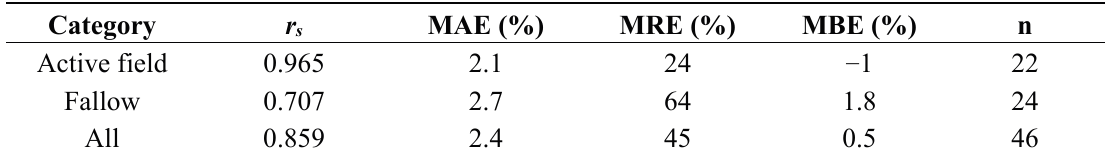
Table 9. Results of accuracy assessment for the delineation of tree canopy cover presented by Spearman’s Rho correlation coefficient ( r s ), mean absolute error (MAE), mean relative error (MRE), and mean bias error (MBE).